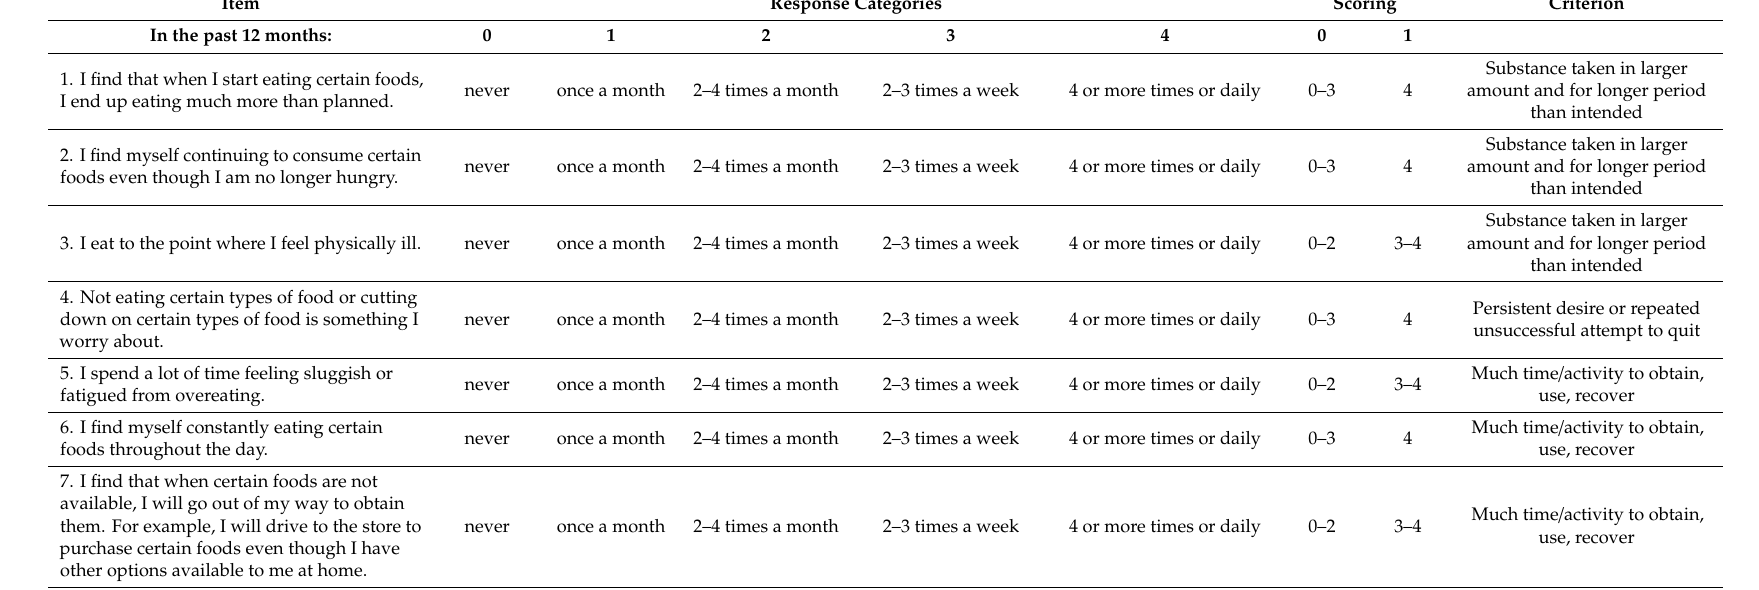
Table A1. Examples of YFAS items and scoring